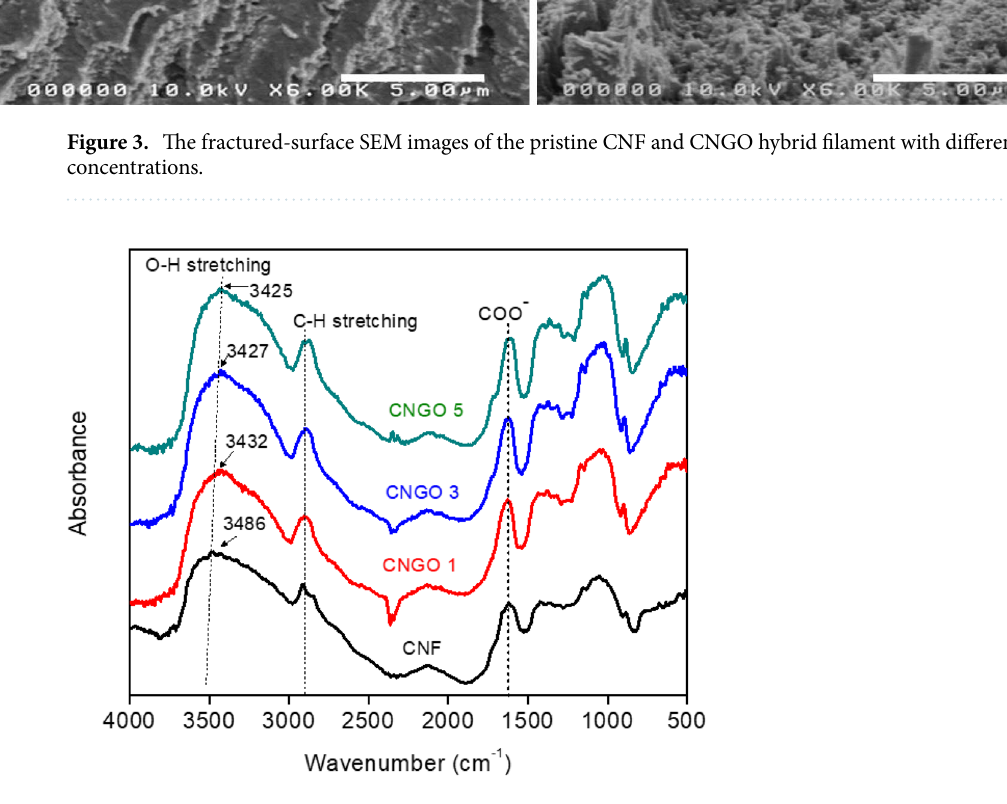
Figure 4. FTIR spectra of the pristine CNF and CNGO hybrid filaments with different GO